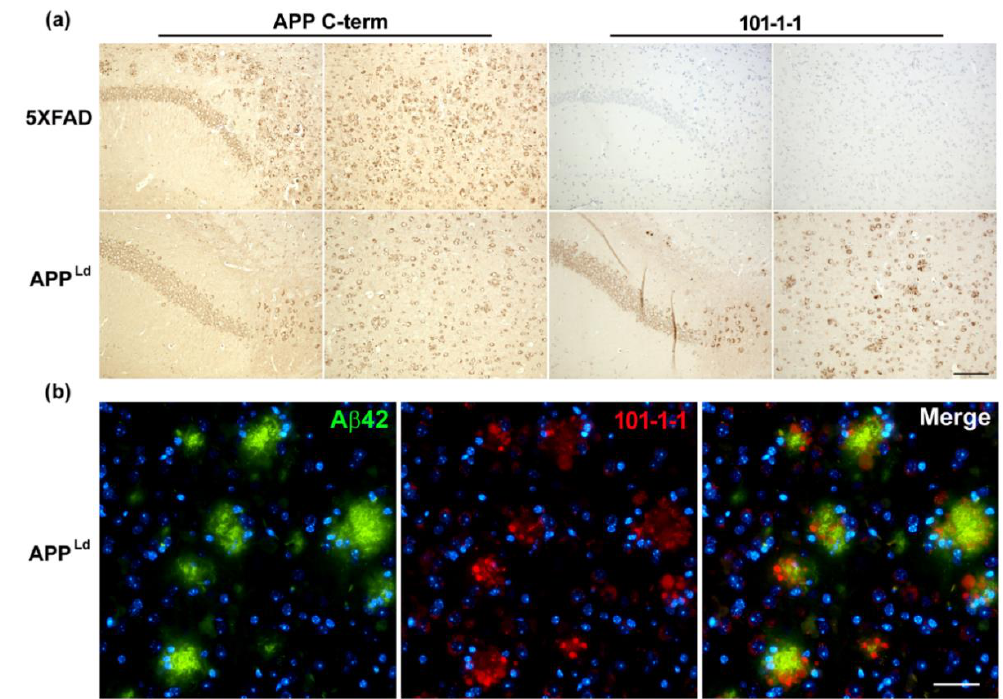
Figure 4. Immunohistochemical staining of Alzheimer’s disease (AD) transgenic mouse models. ( a ) Staining using an antibody directed against the carboxyterminus of APP (APP C-term) showed abundant cellular and neuritic immunoreactivity in 5XFAD and APP Ld mice (left). In contrast, 101-1-1 showed an abundant staining only in APP Ld mice harboring APP with an aminoterminal wildtype (K670–M671) sequence, but a complete lack of immunoreactivity in 5XFAD mice overexpressing APP with the Swedish mutation (N670–L671) (right). ( b ) Double-staining using an A β 42 -specific antibody (D3E10, green) and 101-1-1 (red) revealed abundant A β immunoreactivity in the central amyloid plaque cores, while the 101-1-1 signal was restricted to surrounding dystrophic neurites. Scale bar: 100 µm.